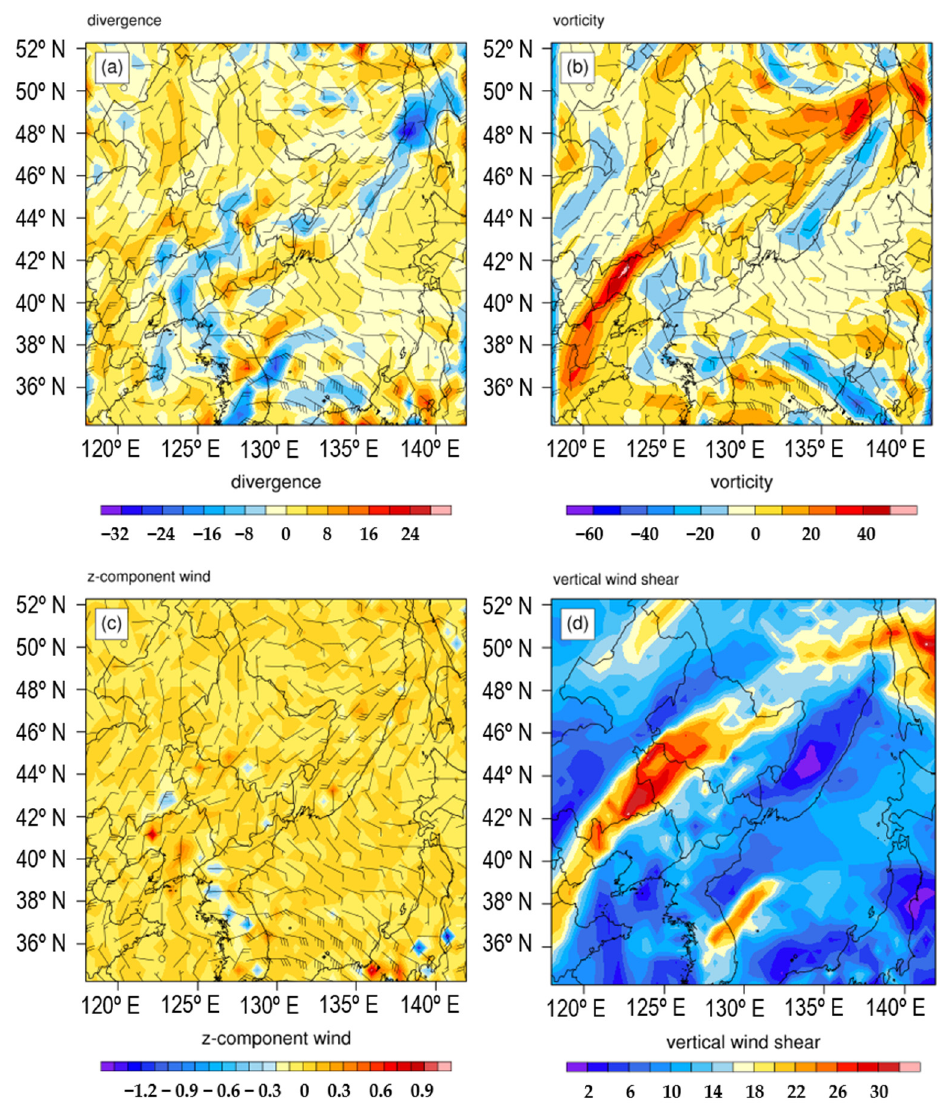
Figure 8. Horizontal winds (barbs;kts) and ( a ) divergence(10 − 5 s − 1 ); ( b ) vorticity (10 − 5 s − 1 ); ( c ) ver- tical velocity (m/s); ( d ) vertical wind shear between 1500–6000 m(m/s) at 19 UTC on 14 August